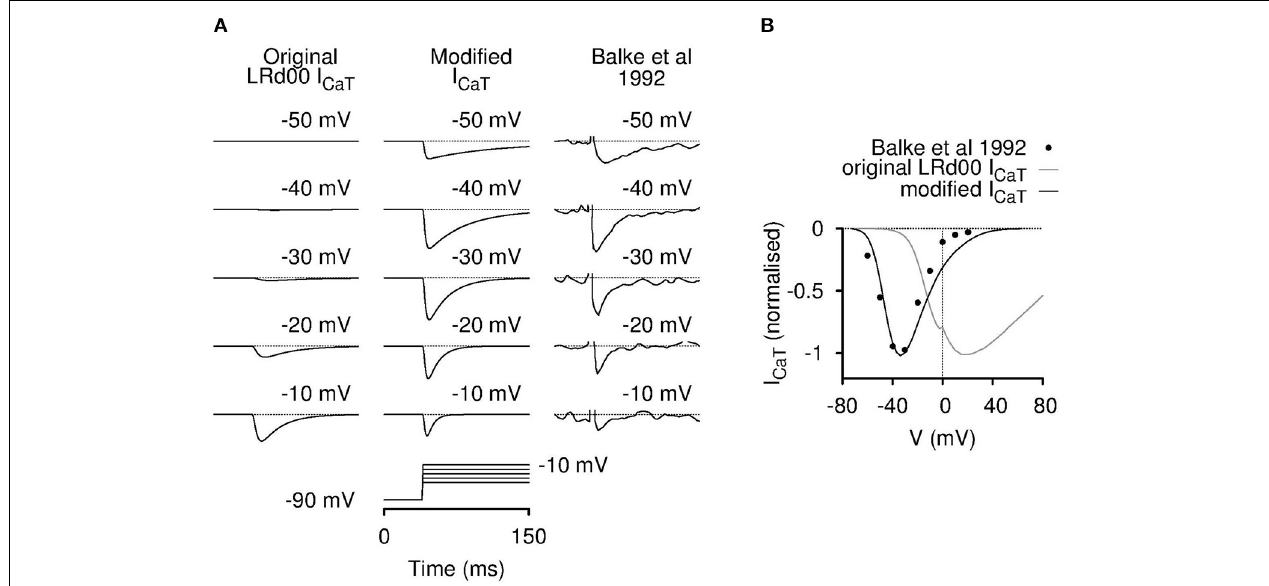
FIGURE 2 | Incorporation of a modified T-type calcium current model for LRd00. The original I CaT contained in the LRd00 cardiac ventricular cell model did not behave like a T-type calcium current. The simulated raw current tracings (A) and the I-V current plots (B) appeared at holding membrane potentials farther to the right than of the experimental data of Balke et al. (1992) that was used as a source experimental dataset. Simulated current tracings at five different voltage steps from a holding potential of − 90mV (A)